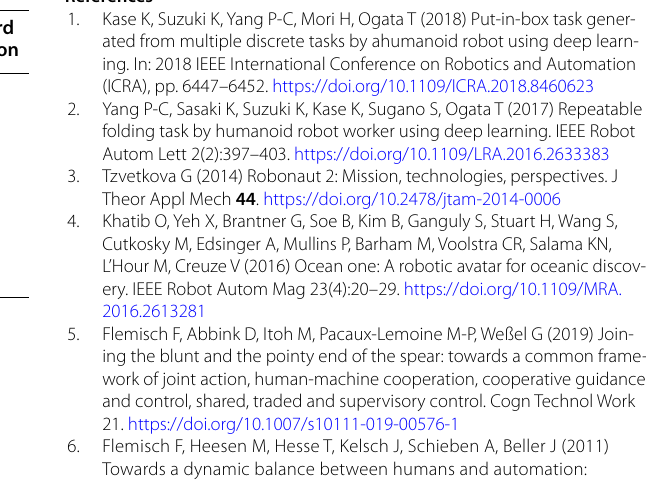
Table 7 Number of times the “dough” was hit with and without the use of indication